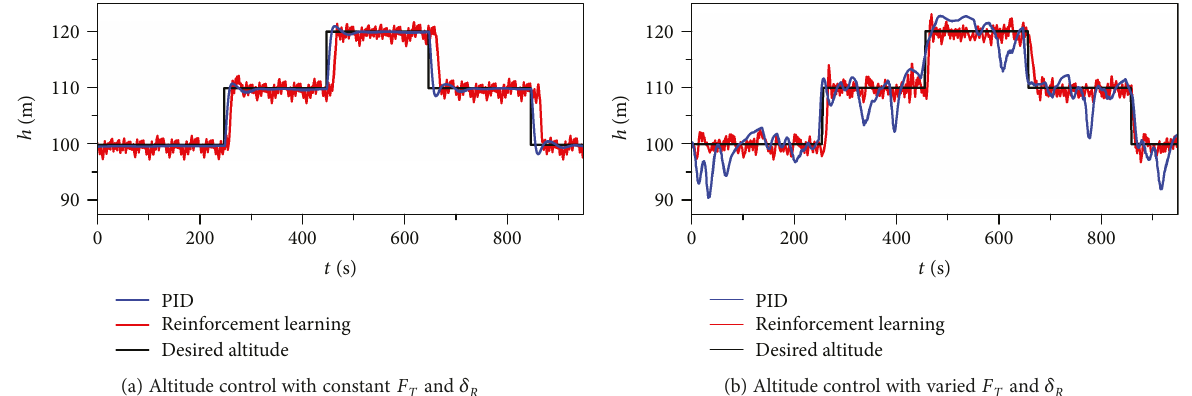
Figure 6: Trend of the success rate and the average time spent.